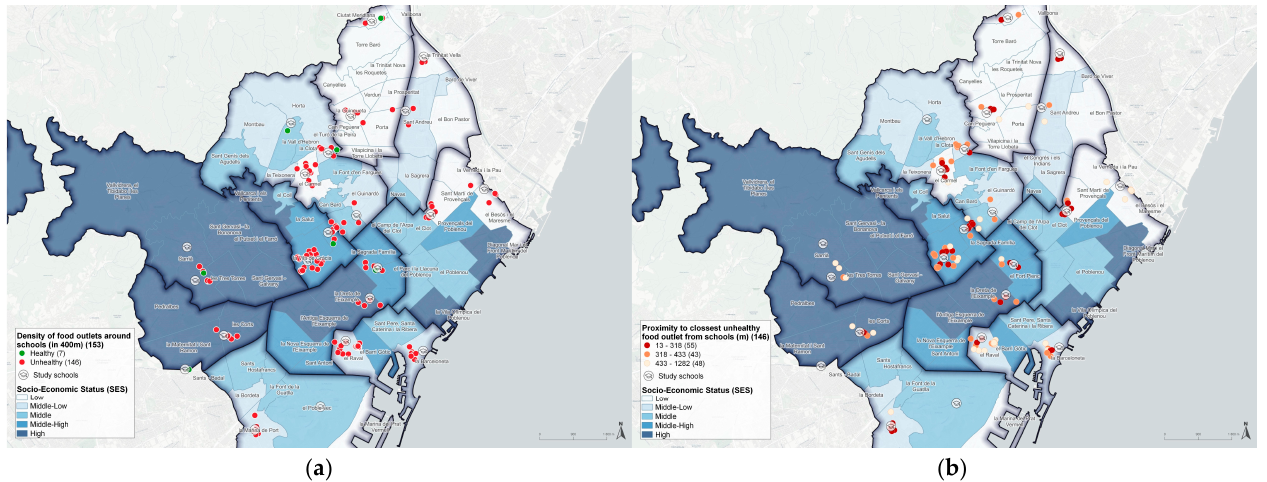
Figure 1. Schools in the city of Barcelona (2019) by neighborhood socioeconomic status (SES): ( a ) shows the availability of retail outlets around schools (within a 400-m radius); ( b ) shows the proximity of unhealthy retail outlets around schools (within a 400-m